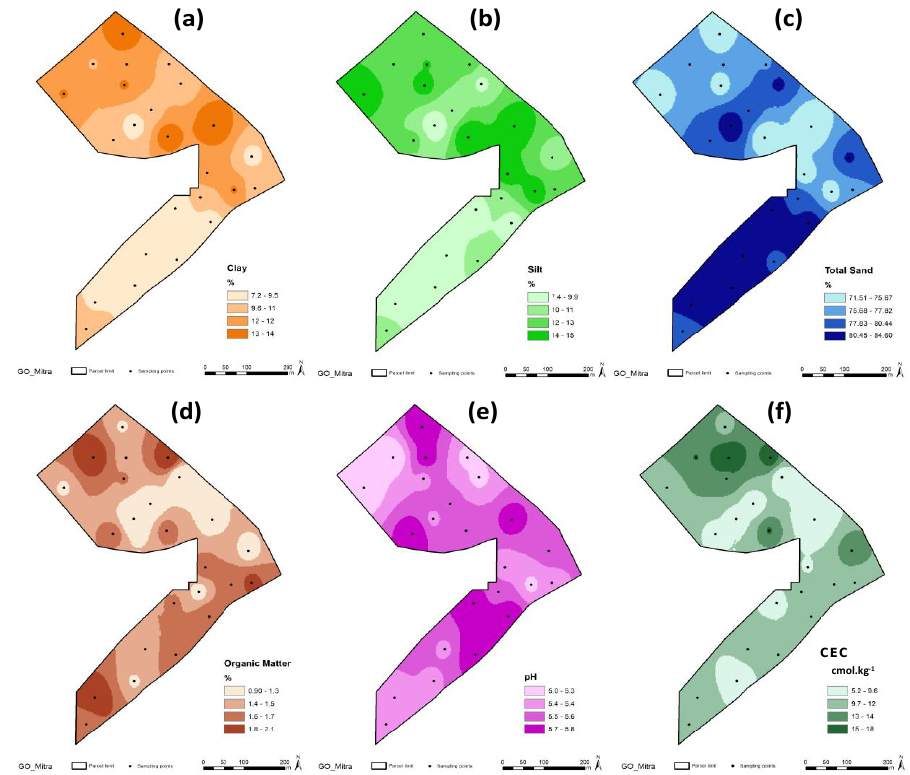
Figure 6. Maps of the soil characteristics: ( a ) clay; ( b ) silt; ( c ) sand; ( d ) organic matter; ( e ) pH; and ( f ) cationic exchange capacity (CEC). Figure 7 shows the elevation (a) and EC a (b) maps. These highlight the slightly undulating topography, characteristic of this region, and the very low EC a values (<5 mS.m; Figure 7b), typical of coarse-textured and dryland soils [24,35].